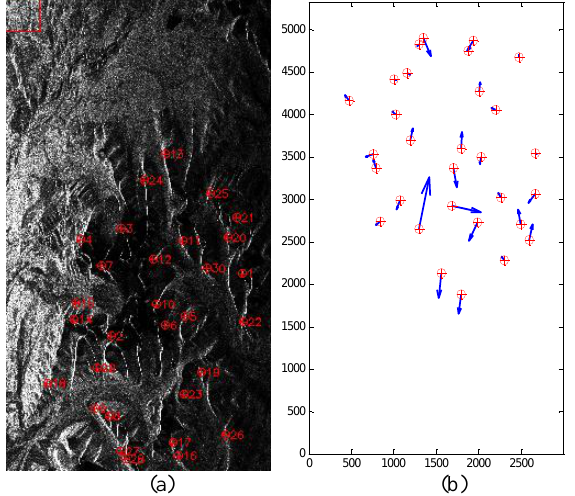
Figure 3. (a) Fusion real SAR image (left) and (b)ICPs vectors (right).